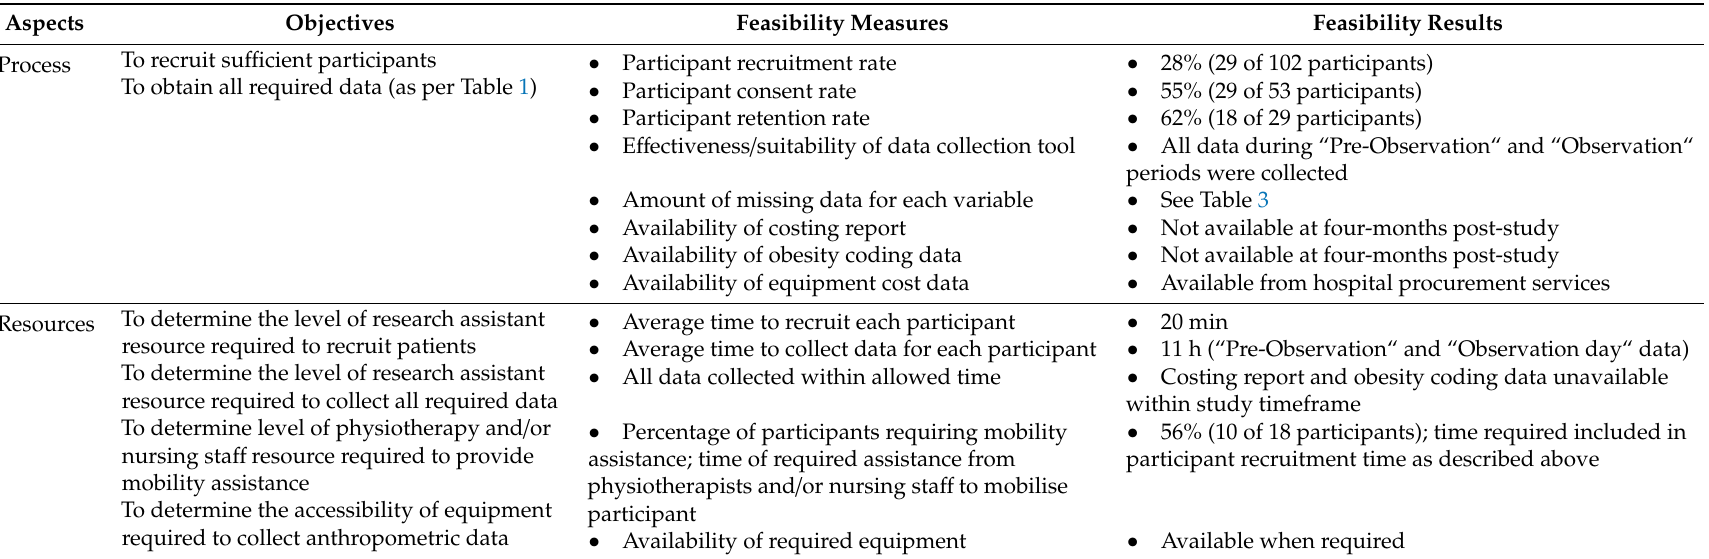
Table 2. Summary of study feasibility objectives, measures and